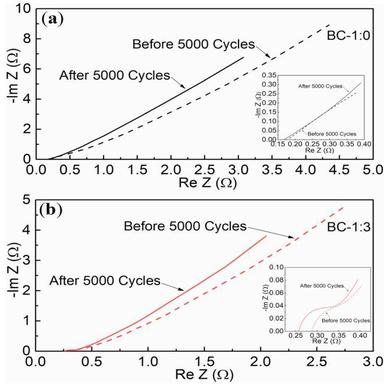
Electrochemical impedance spectra (EIS) of the symmetric supercapacitor made using (a) intrinsic and (b) nitrogen doped DDGS biocarbon.